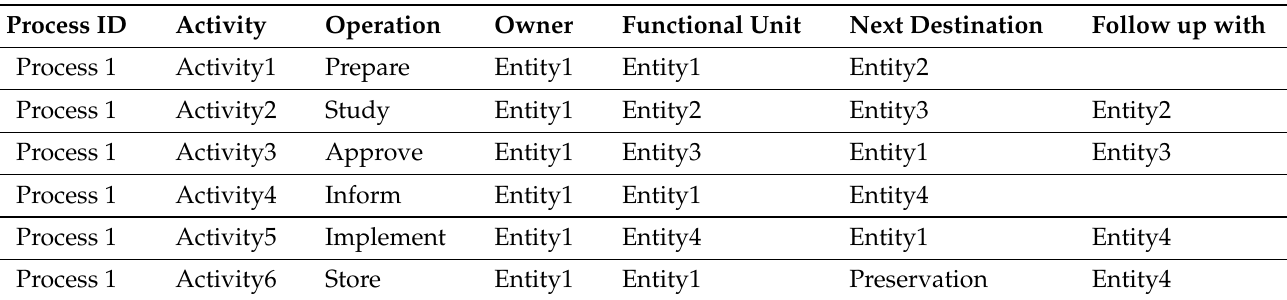
Table 1. Reservation station